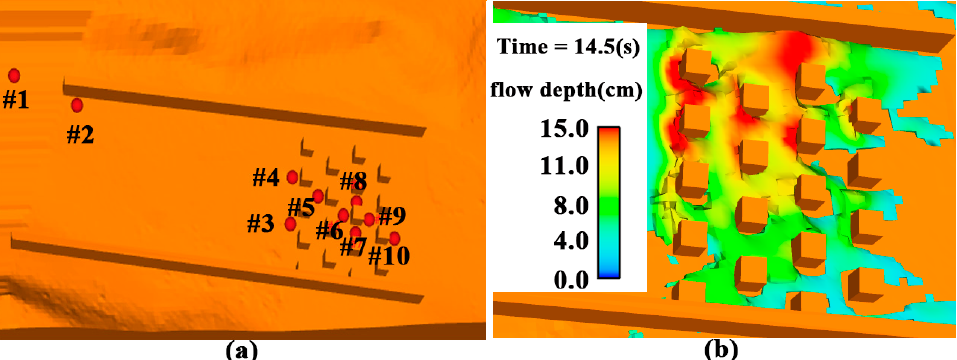
Figure 6. Numerical validation. (a) arrangement of probe points; (b) flow depth distribution at T =